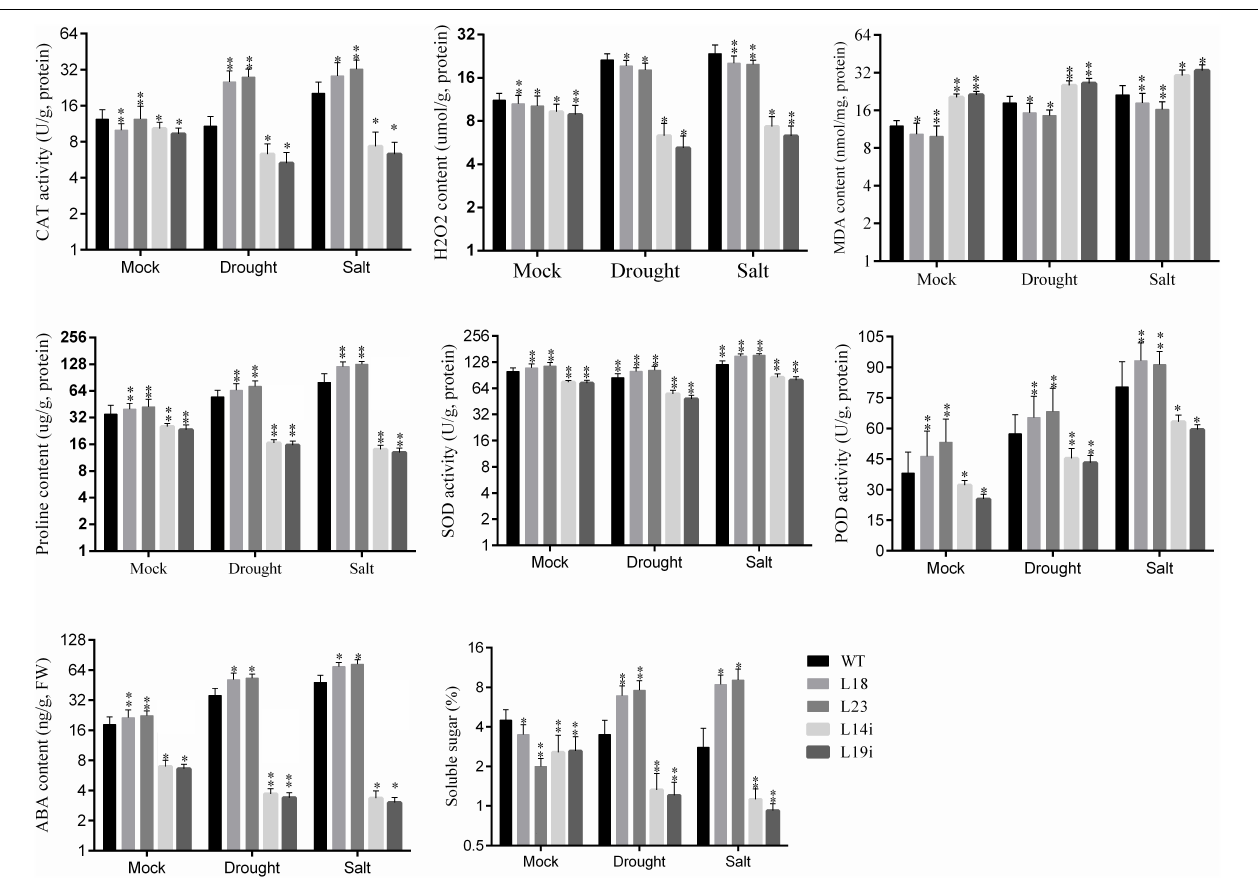
FIGURE 5 | ABA content, soluble sugar, Malondialdehyde (MDA), hydrogen peroxide (H 2 O 2 ) and antioxidant enzymes [catalase (CAT), superoxide dismutase (SOD), and peroxidase (POD)] activities in WT and transgenic lines (L18 and L23) under drought and salinity. Data represent mean of ± SE for three independent biological replicates ( n = 3) and each replicate contained 6 plants. ∗ and ∗∗ represent the significant difference as determined by t -test ( P -value ≤ 0.01 ∗∗ /0.05 ∗